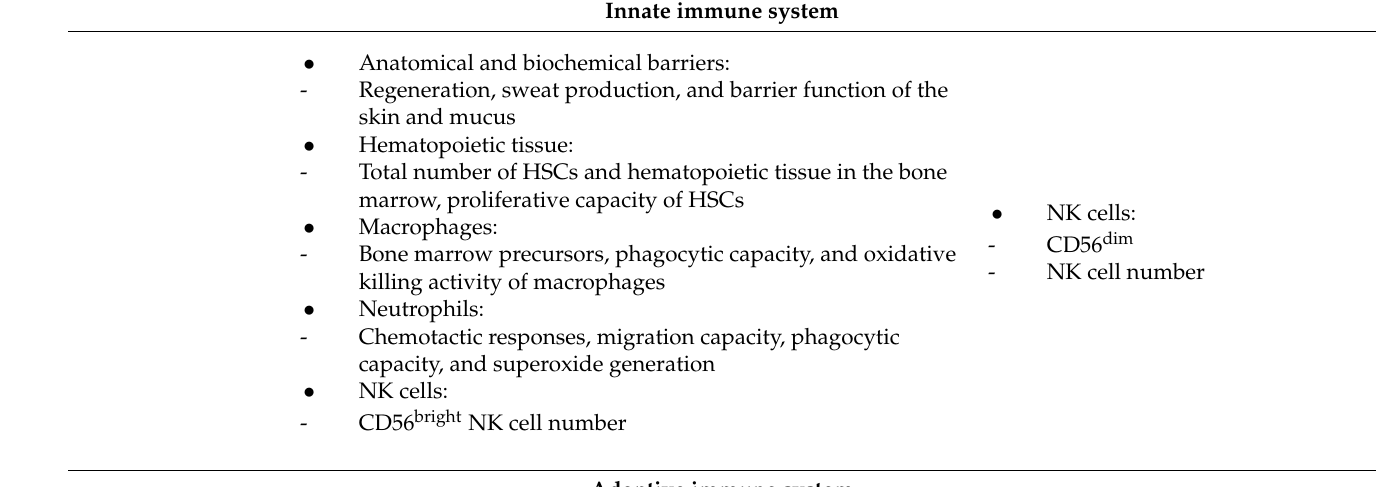
Table 1. Immunosenescence: modifications of the immune response with aging. Decreased Increased Innate immune